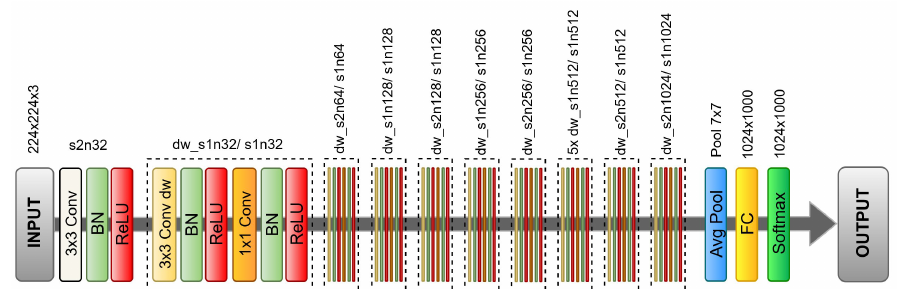
Figure 4. MobileNet network architecture. Depthwise and pointwise convolutions are used through out the entire model drastically reducing the number of parameters required. Coonvolutions with strides s two are used in substitution of Max-Pooling operations.